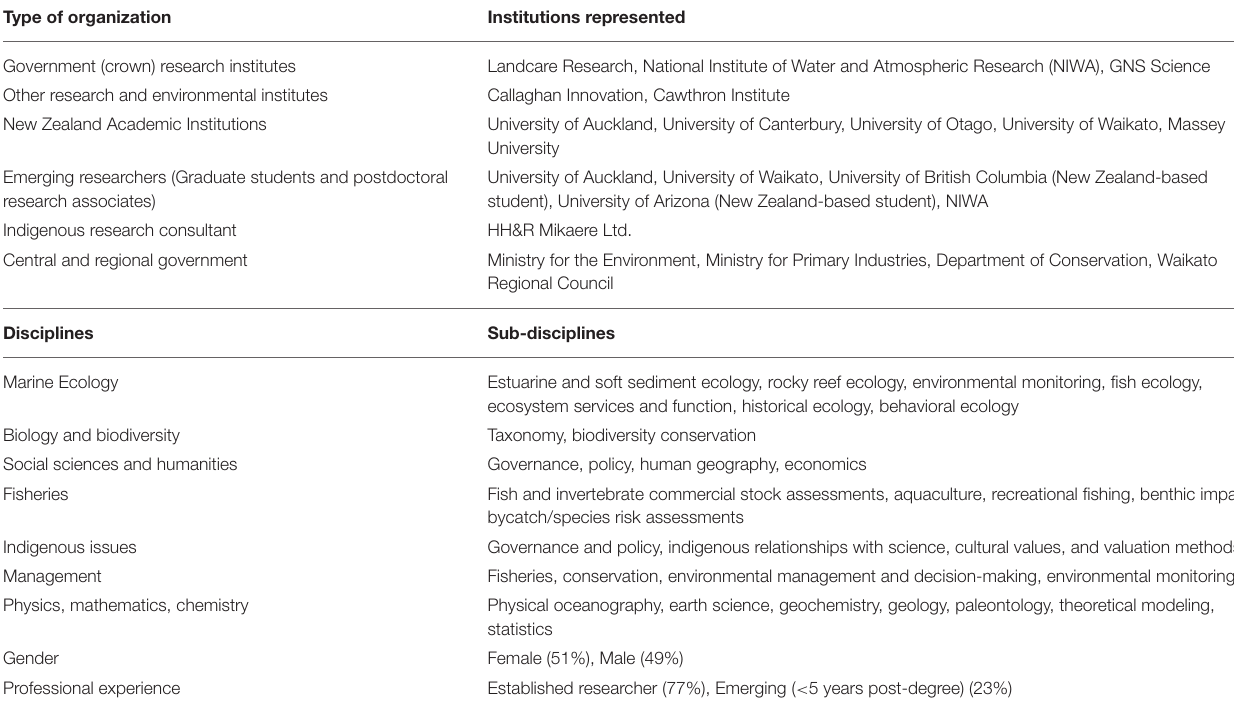
TABLE 1 | Types of organizations and disciplines of participants involved in survey and